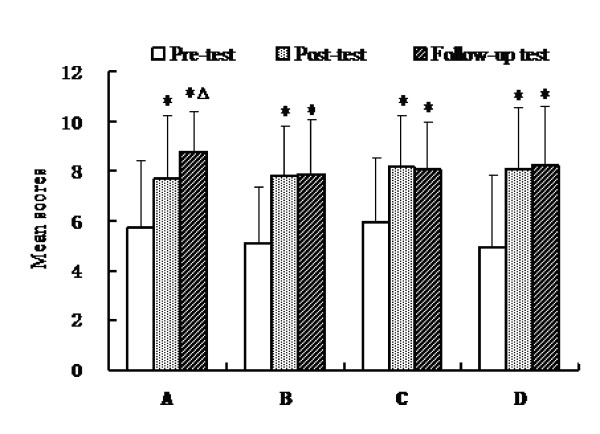
The mean knowledge scores of participants at pre-training, post-training, and follow-up time periods (N = 41). Data are shown as mean ± SD. All comparisons were performed by one way ANOVA. Abbreviations: A: Emergency analytic/assessment knowledge; B: Basic public health science knowledge; C: Basic culture knowledge; D: Program planning and management knowledge; Pre-test: The mean scores of pre-training; Post-test: The mean scores of post-training; Follow-up test: The mean scores of 12-month later. Symbols: *P < 0.05 vs. Pre-training; ΔP < 0.05 vs. Post-training.